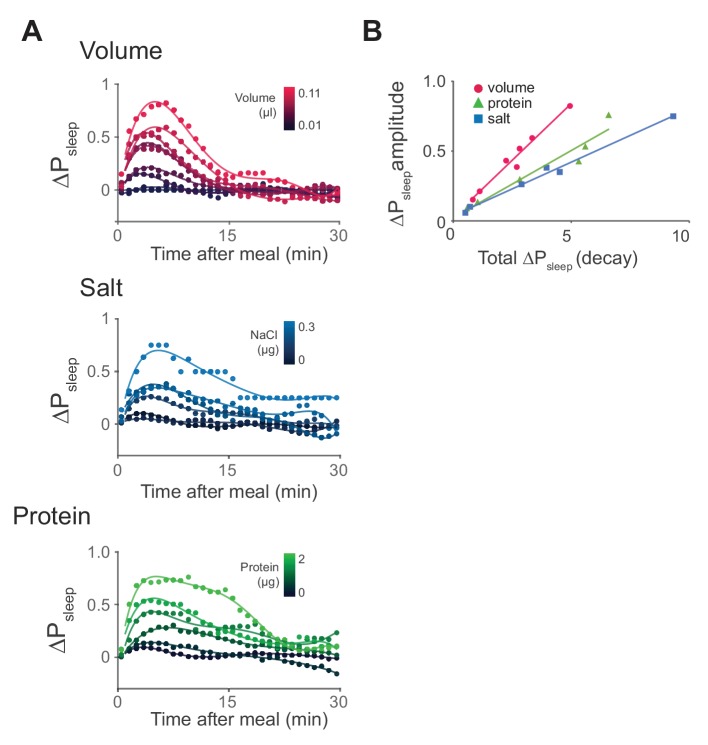
Time-course analysis of sleep in response to meal components reveals differential kinetics.(A) Time-course analysis of ΔPsleep for meals of graded volume, protein, or salt consumption (circles represent 1 min binned averages, lines represent spline fit). n = 811 meals, volume; 714, protein; 478, salt; 1131, sucrose. (B) ΔPsleep amplitude for gradings of volume, protein, and salt plotted against total ΔPsleep during the decay phase 20 min following the maximum.